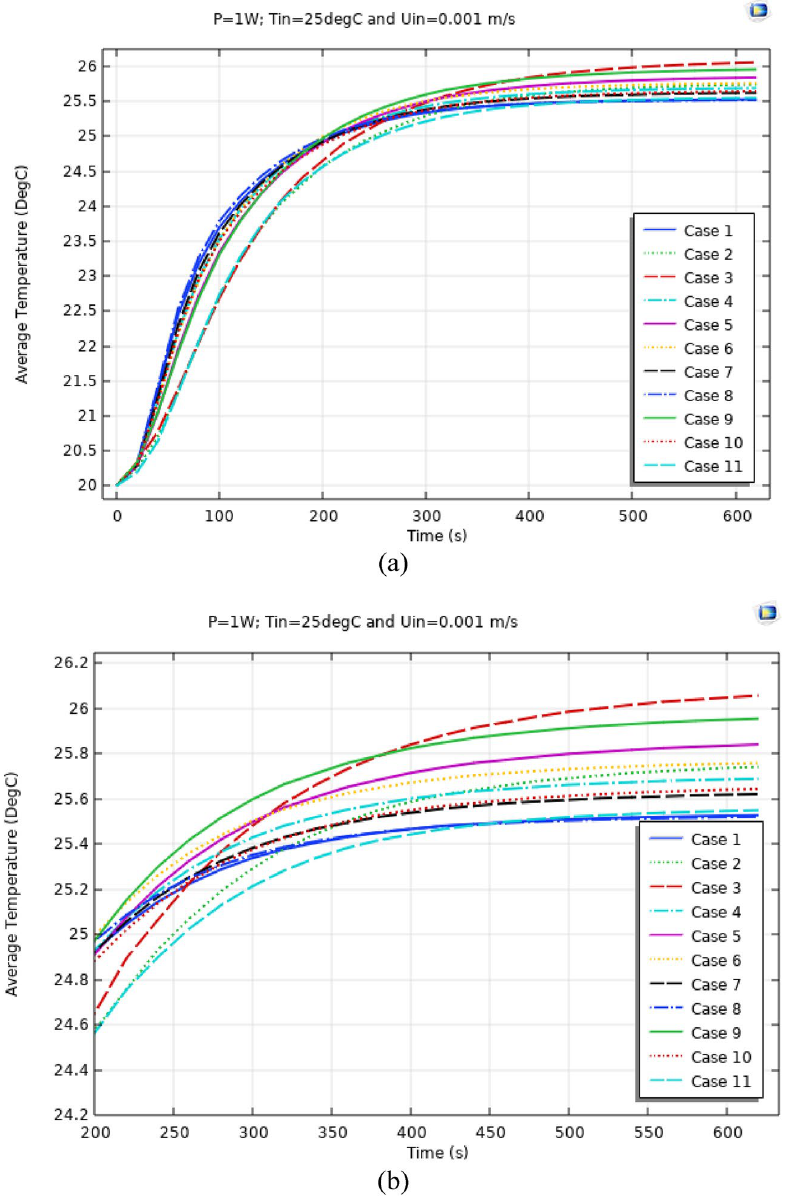
Figure 11. Average Temp. when P = 1 W for different 11 cases ( a ) complete view, ( b ) zoomed